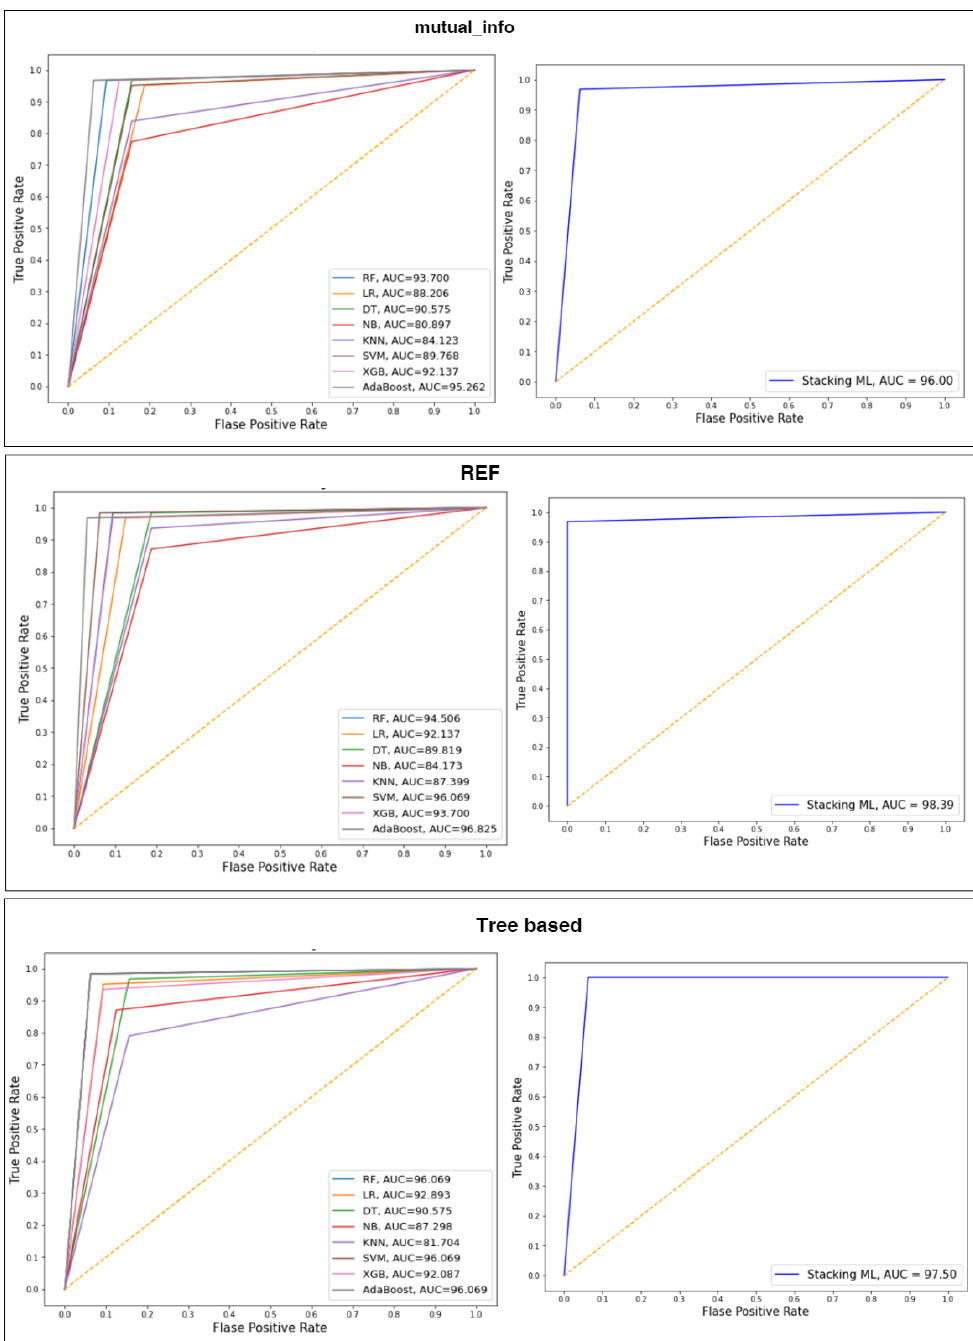
Figure 7. ROC curves of splitting